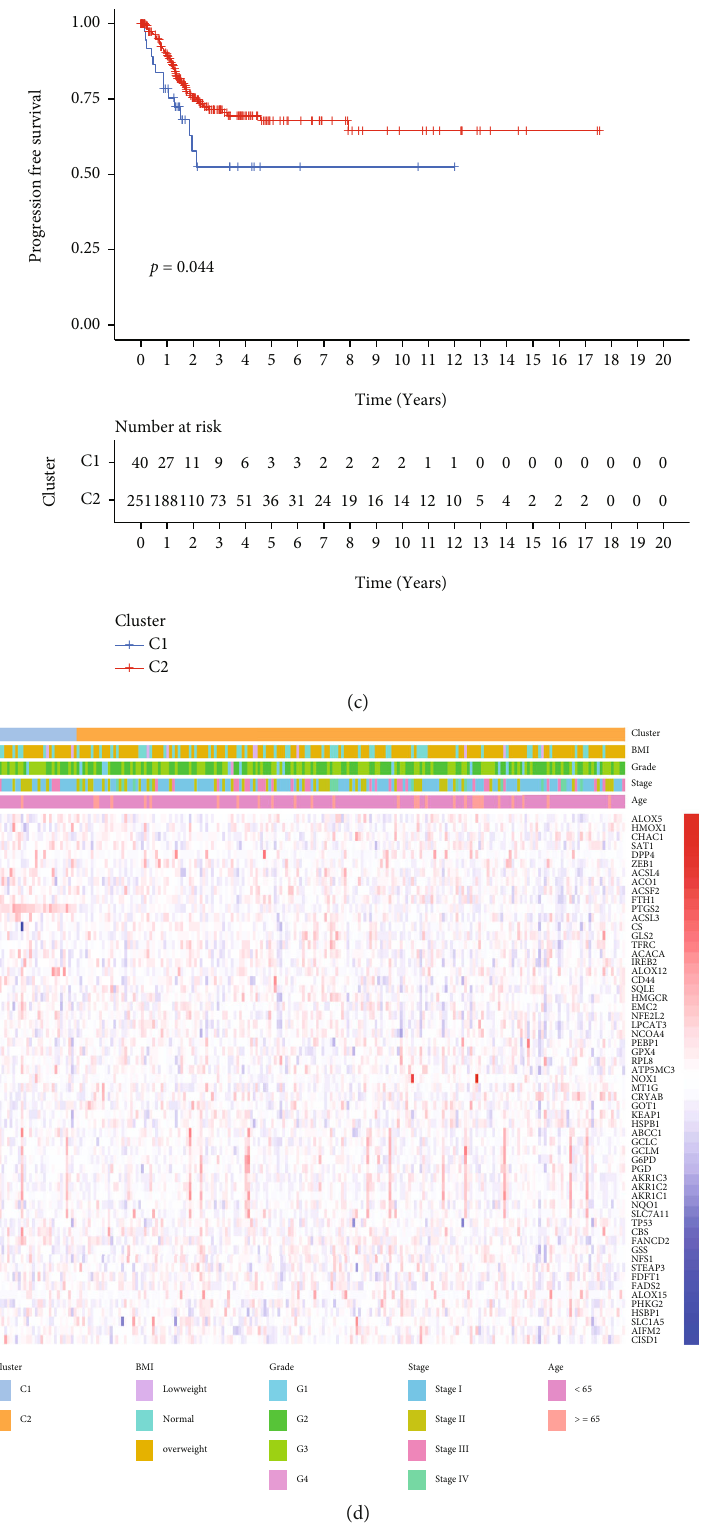
Figure 1: Identi fi cation of ferroptosis-associated subtypes using nonnegative matrix cluster analysis. (a) The optimal k value was determined to be 2, and TCGA cervical cancer samples could be divided into two subgroups, C1 and C2. (b, c) K-M survival curves of overall survival (OS) and disease-free survival (PFS) in C1 and C2 subgroups. (d) Heat map of age, stage, grade, BMI, and ferroptosis-related gene expression across